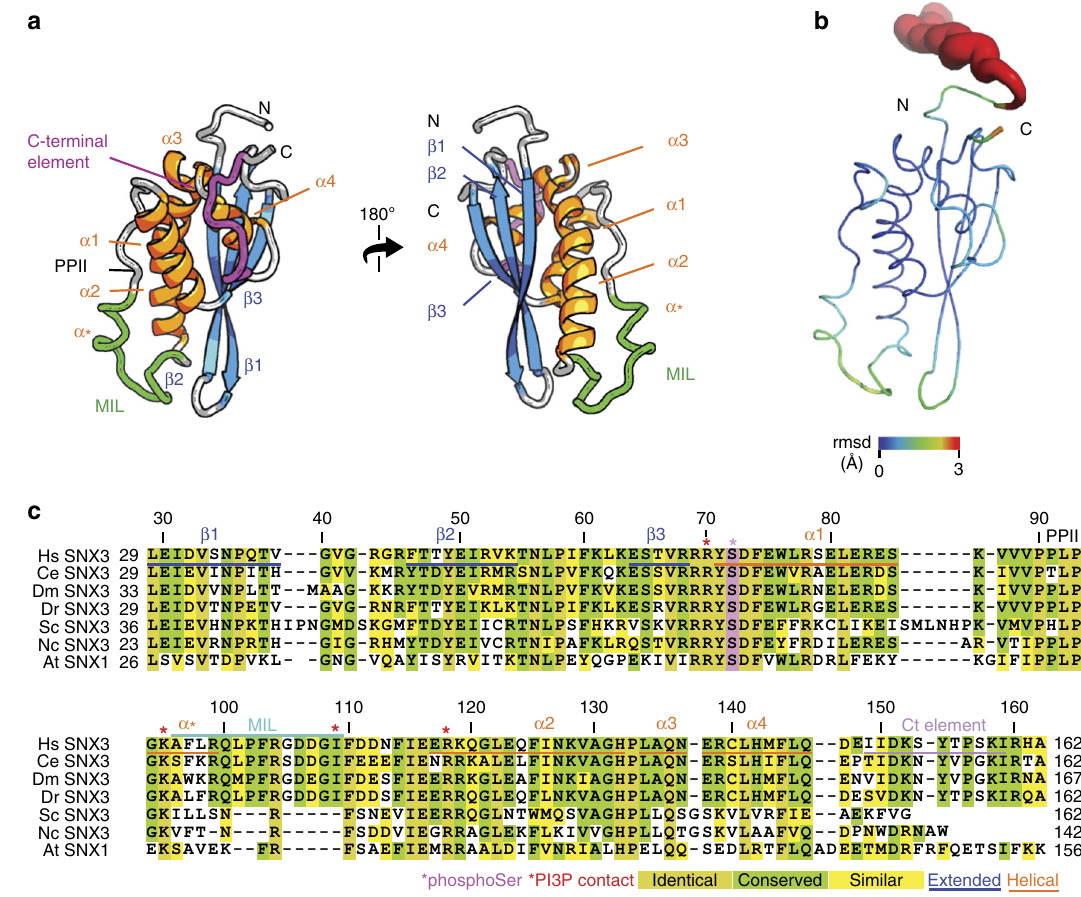
Fig. 1 Solution structure of human SNX3. a The structure of SNX3 closest to the mean is shown in two perspectives with regular secondary structures, including four α -helices (orange) and three anti-parallel β -strands (blue). The segment delimited by α 1 and α 2-helices contains a polyproline type II helix (PPII) and α helical elements by the membrane inserting loop (MIL). The C-terminal segment is highlighted in magenta. b The ensemble of structures is represented as a sausage representation of the backbone traces, with the thickness and color being related to the pairwise r.m.s. deviation up to a cut-off at 3 Å (see inset scale). c Structure-based alignment of the SNX3 PX sequences. The C-terminally extended PX domains of SNX3 proteins from Homo sapiens (Hs), Caenorhabditis elegans (Ce), Drosophila melanogaster (Dm), Danio rerio (Dr), Saccharomyces cerevisiae (Sc, also known as Grd19p), and Neurospora crassa (Nc), as well as SNX1 from Arabidopsis thaliana (At), as there is no SNX3 homolog in this species, were aligned with Clustal 53 . Absolutely conserved, identical, and similar residues are shaded in brown, green, and yellow, respectively. The residues corresponding to Hs SNX3 Ser72 are magenta, and those that contact PI3P are indicated with a red asterisk. The positions of helices and extended elements are underlined and